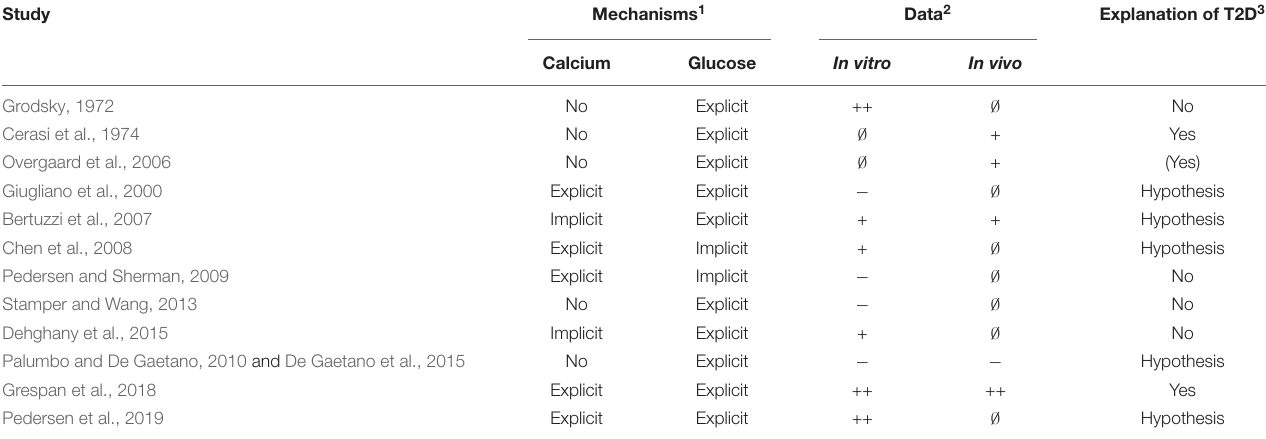
TABLE 1 | Summary of the β -cell